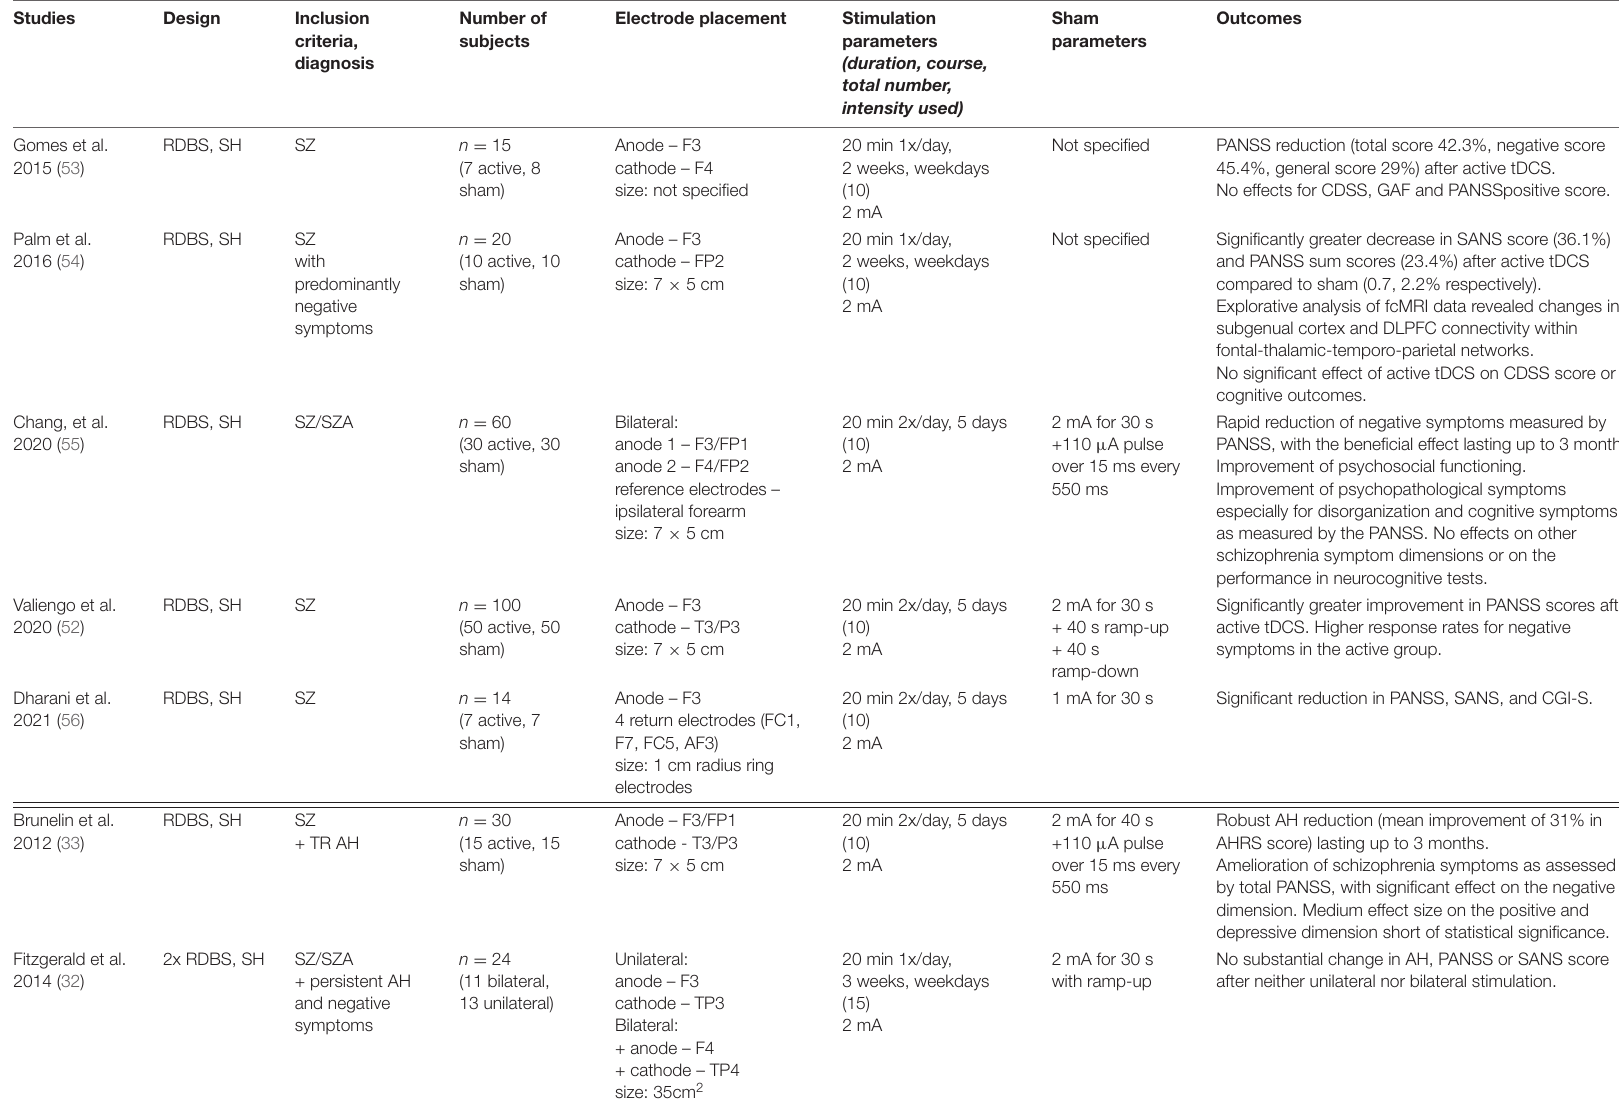
TABLE 2 | Effects of tDCS on negative